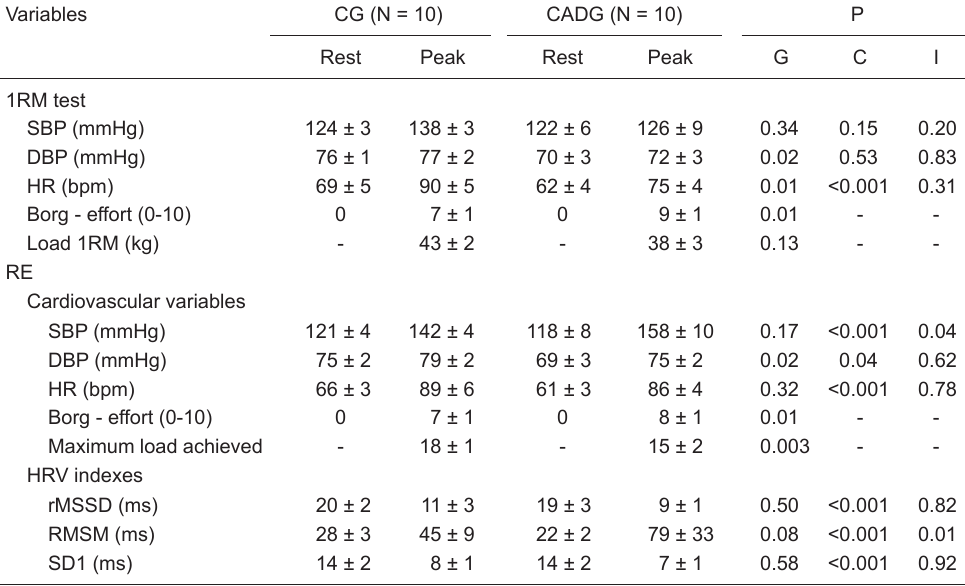
Table 2. Cardiovascular variables and load obtained during one repetition maximum (1RM) test and heart rate variability indexes obtained at the peak and during the rest of resistance exercise (RE).